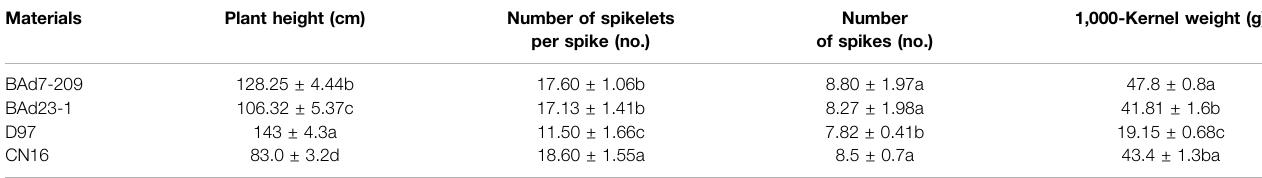
TABLE 1 | Agronomic characteristics of BAd7-209, BAd23-1, CN16, and D97 Materials Plant height (cm) Number of spikelets